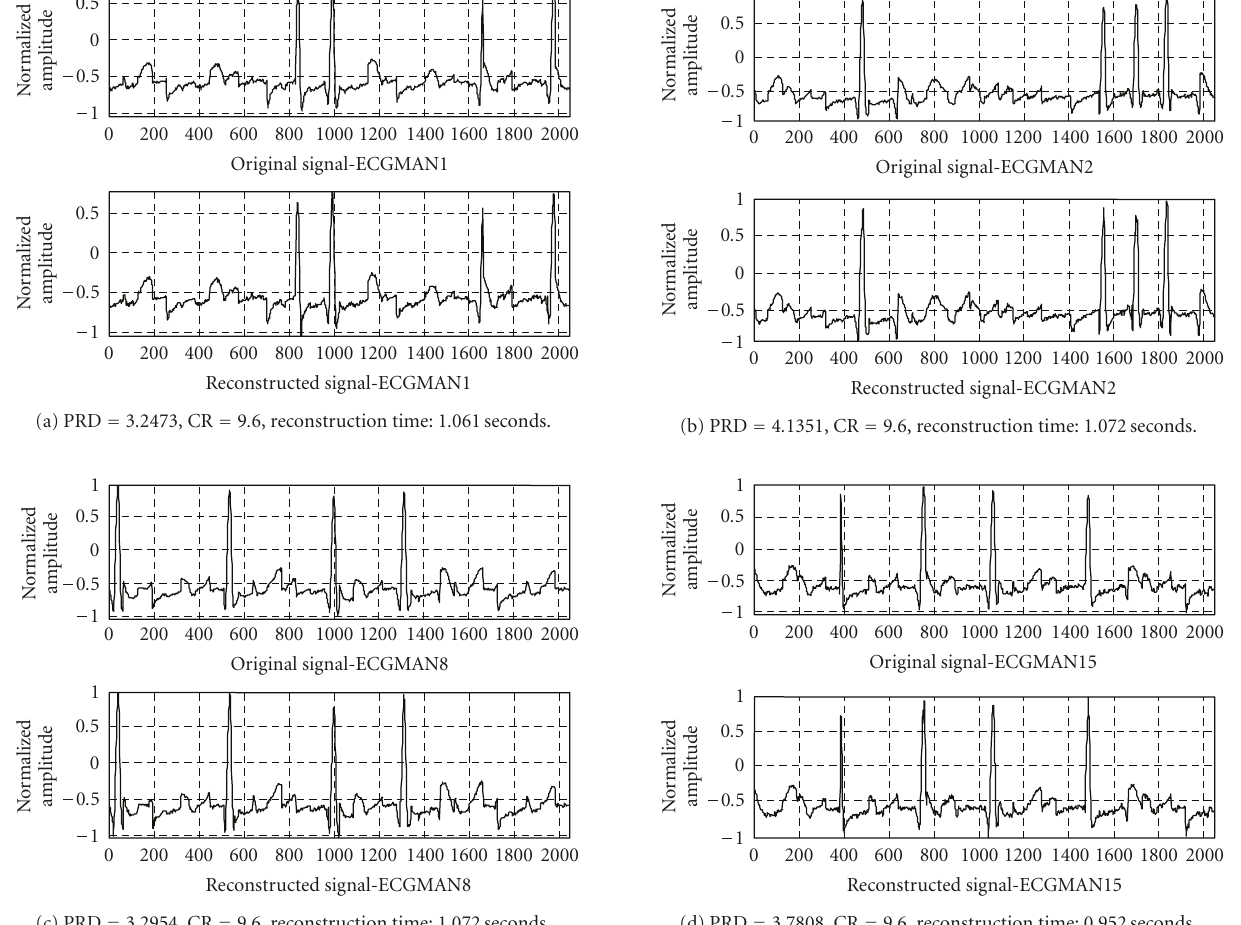
Figure 6: Original and reconstructed ECG signals for L F = 16.